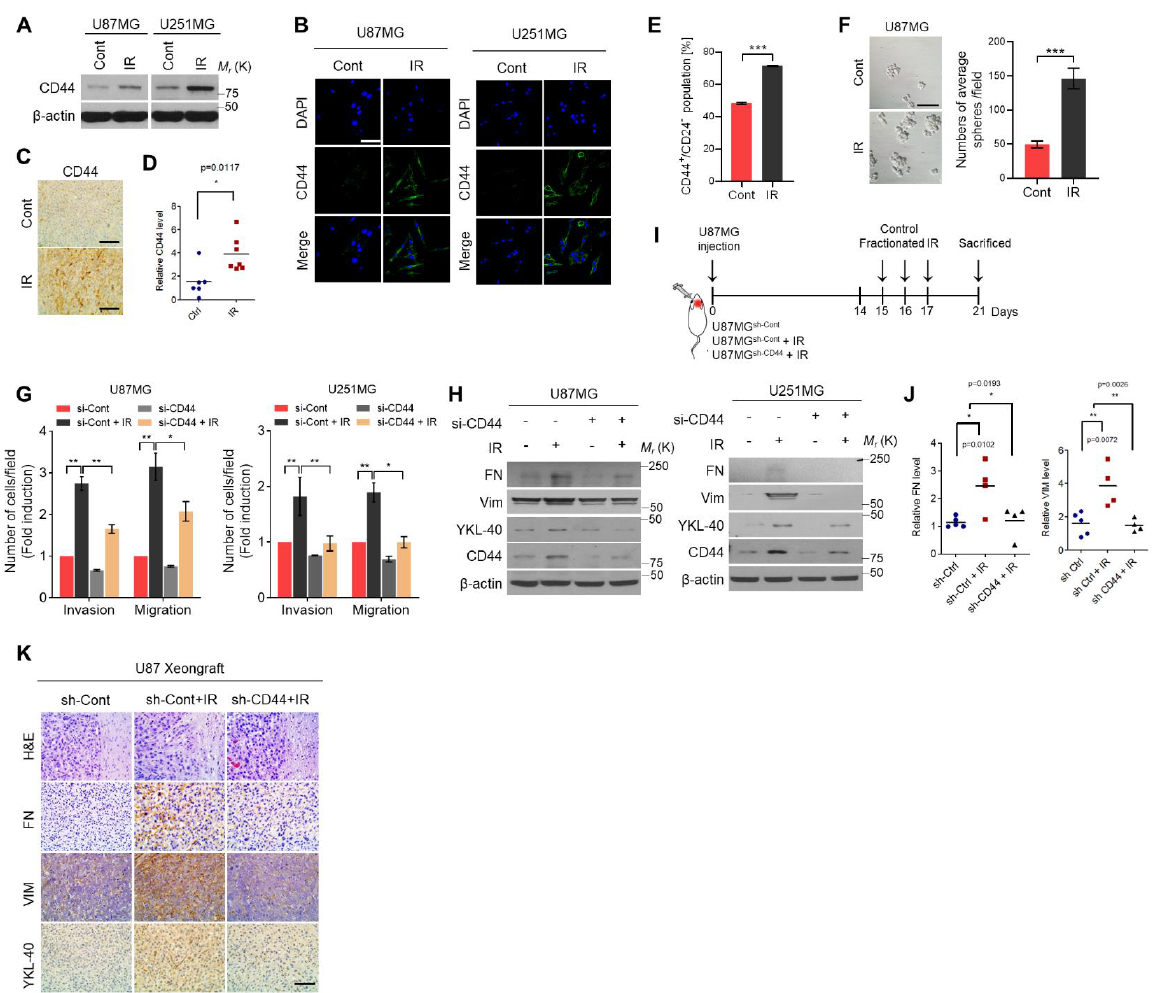
Figure 1. IR induced CD44 expression and promoted mesenchymal shift of GBM. ( A , B ). Western blot analysis and ICC staining assay were performed to check the CD44 expression in IR treated-U87MG cells. ( C ). Representative IHC staining images of CD44 expression of in mice tissues with or without ionizing radiation treatment. ( D ). The graph showed the intensity scores of CD44. ( E ). FACS analysis of the percentage number of CD44 + /CD24 − in IR treated-U87MG cells. ( F ). Sphere formation assay showed that the cancer stemness features of GBM was increased after treated with the IR. ( G , H ). Invasion and migration assay, western blot analysis were performed to check the invasiveness ability of cells and mesenchymal markers expression in IR-induced U87MG and U251MG cells along with blocking CD44 expression. ( I ). Schematic of in vivo experiments. A total of 2 × 10 5 U87MG GBM cells were injected into each mouse (sh-Ctrl ( n = 5); sh-Ctrl+IR ( n = 4); sh-CD44+IR ( n = 4)) using a multiple micro-infusion syringe pump (Harvard Apparatus, Holliston, MA, USA) at a speed of 0.5 μL/min. ( J , K ). Representative H&E and IHC staining images of FN and VIM expression in mouse tissues. The graph showed the intensity score of FN and VIM expression. β-actin was used as a control for normalization of expression. * p < 0.05, ** p < 0.01, *** p < 0.001, n.s., not significant. A two-tailed Student’s t -test was used to compare data between two groups, and ANOVA was used for multiple comparisons.